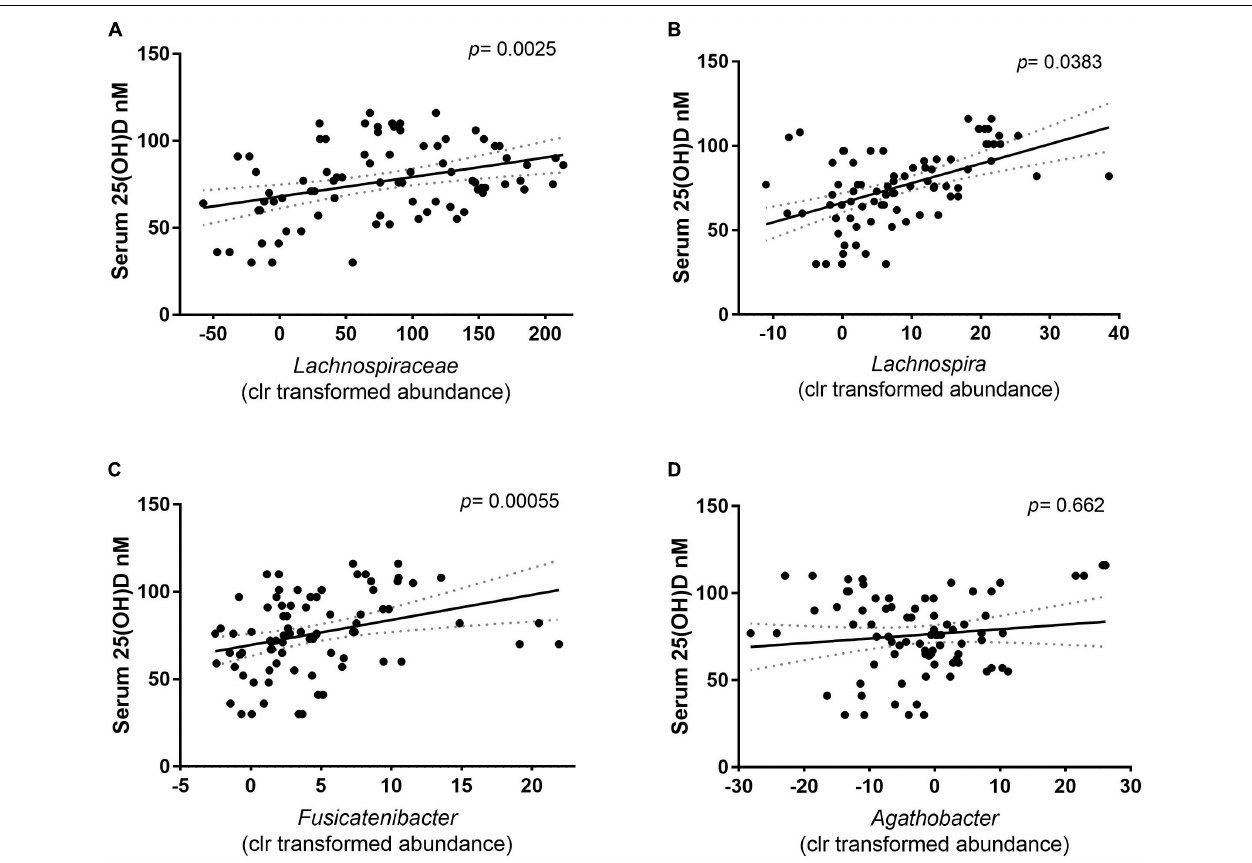
FIGURE 5 | Correlation of the relative abundance (clr) and the serum 25(OH)D concentration of the participants. The solid line depicts the mean and dotted area the calculated error of the mean. Each dot depicts the centered log ratio relative abundance per sample ( n = 81). (A) The association of the family Lachnospiraceae with serum 25(OH)D concentration showed a positive correlation. Correlation was calculated with a mixed- effect regression of abundance against the serum 25(OH)D concentration, of which the difference was tested with a Chi square distribution test ( p = 0.0025). (B) At genus level, Lachnospira ( p = 0.0383), and (C) Fusicatenibacter ( p = 0.000055) clr relative abundance is positively correlated with the serum 25(OH)D. (D) The relative abundance of Agathobacter is independent of the serum 25(OH)D concentrations ( p =